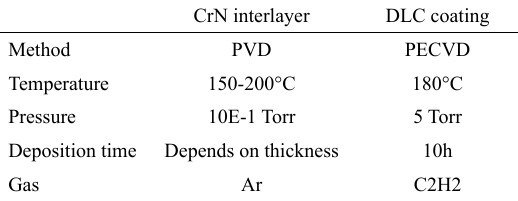
Table 1. Deposition of interlayer and final coating parameters.